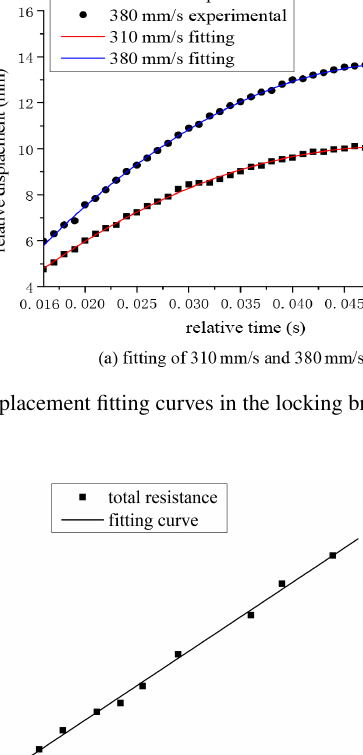
Figure 14. Lock and start driving switching strategy.